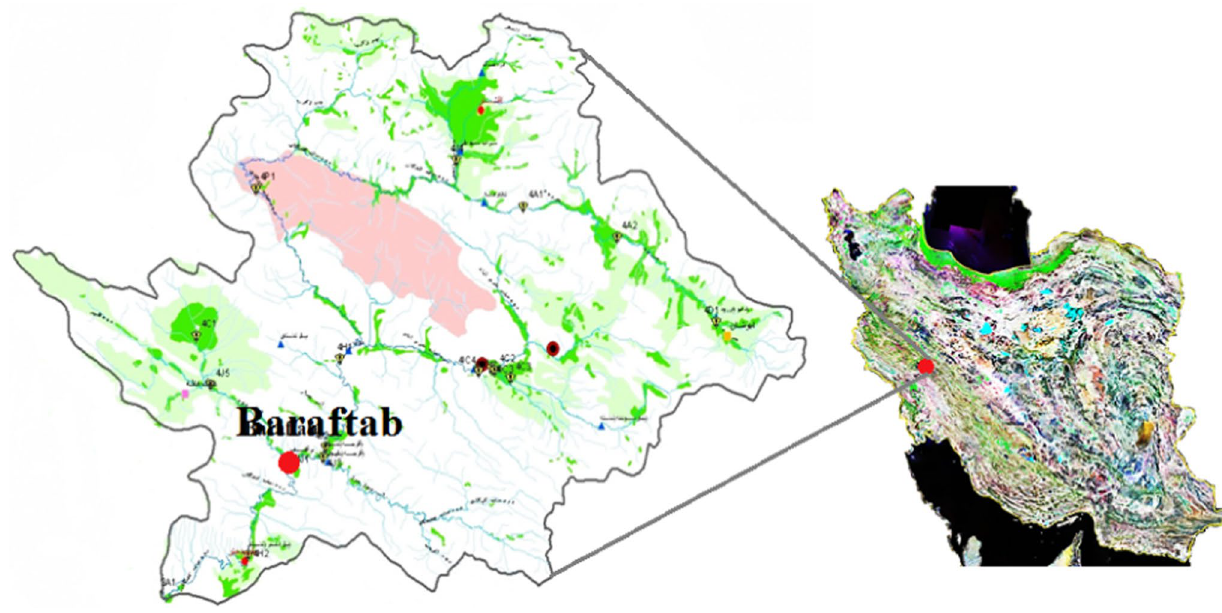
Fig. 1 The site of the investigation